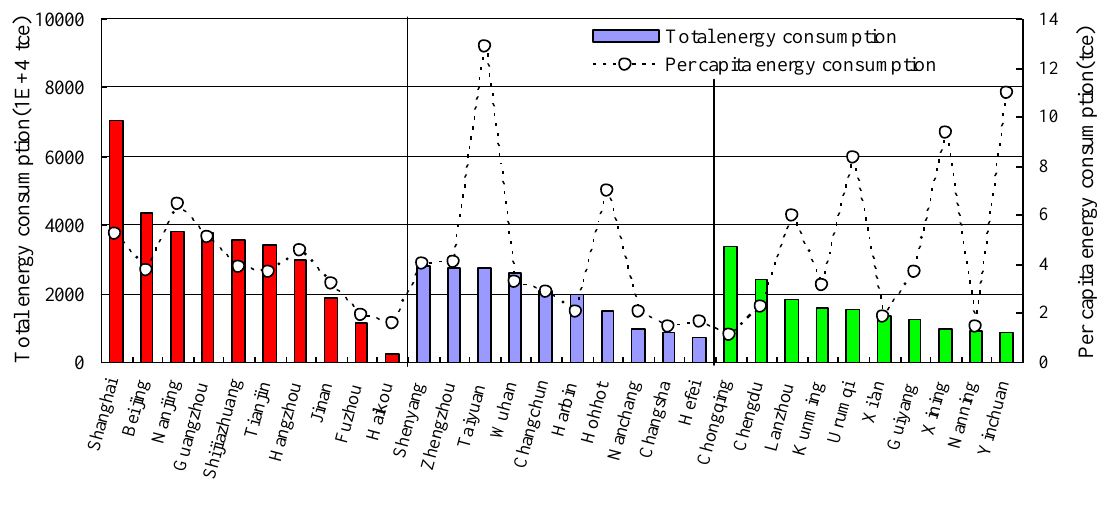
Figure 2. Spatial distribution of total energy consumption of the 30 case cities in China in